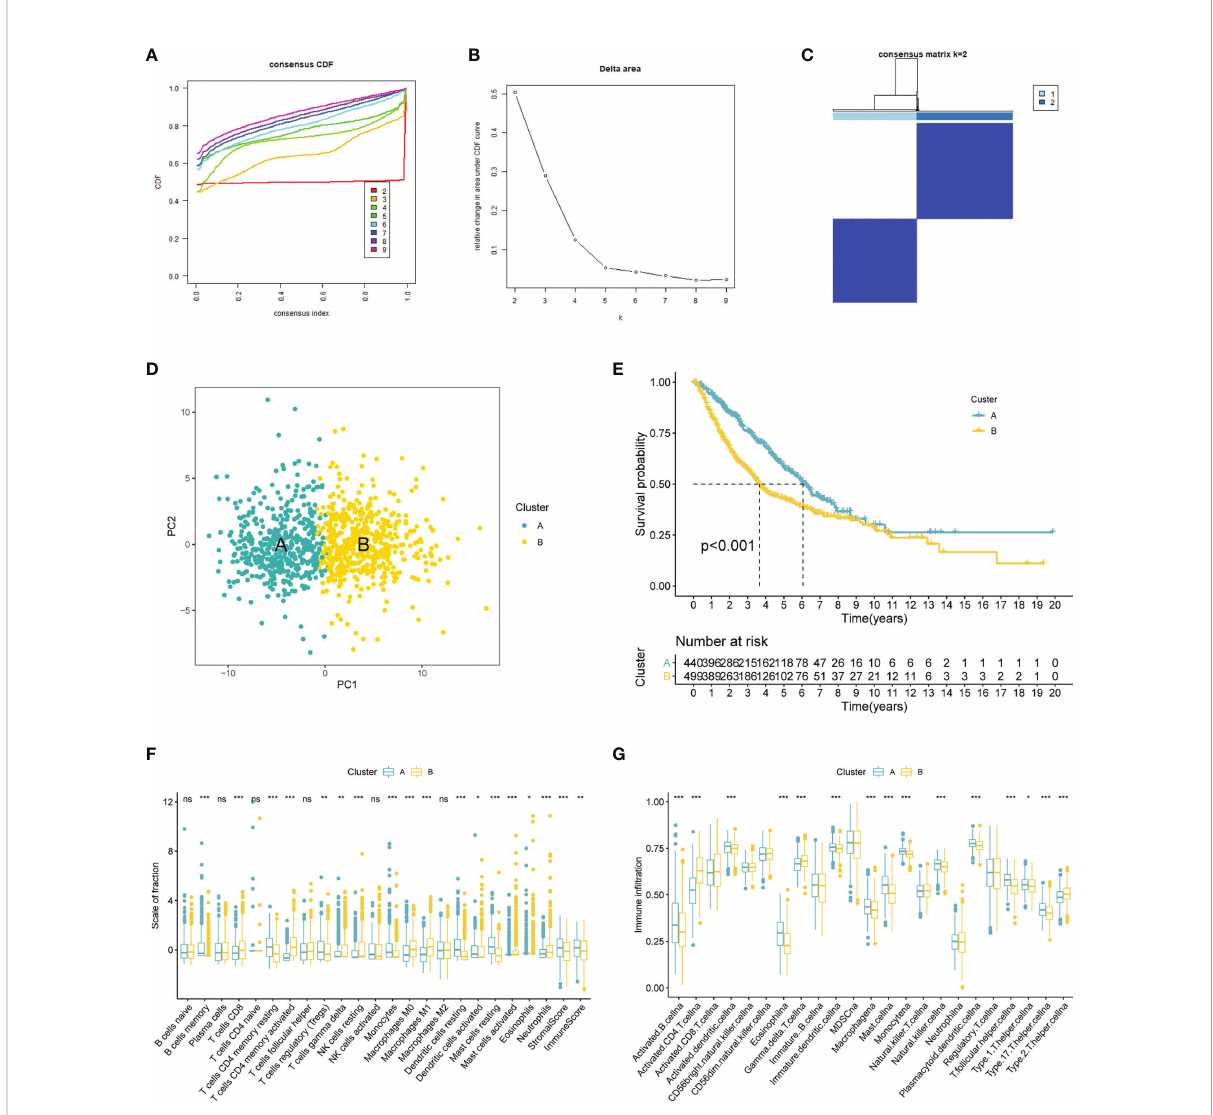
FIGURE 2 CRs-associated clustering analysis. (A, B) The CDF value of consensus index. (C) Consensus matrix for k=2. (D) Principal component analysis of the entire LUAD set. (E) The Kaplan – Meier survival analysis. (F) Comparison of immunocyte proportions of the CRs-based clusters. (G) The differences of TME score 22 the two clusters. ns, no signi fi cance; 0.05; *p < 0.05; **p < 0.01; ***p <